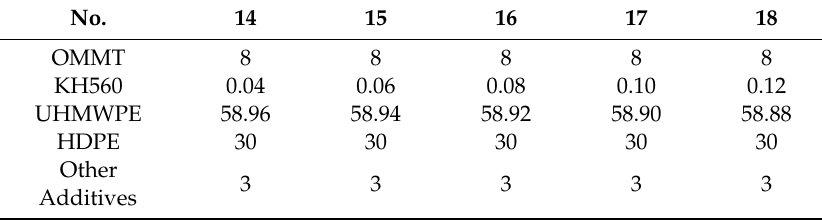
Table 5. Mass fraction of each component /